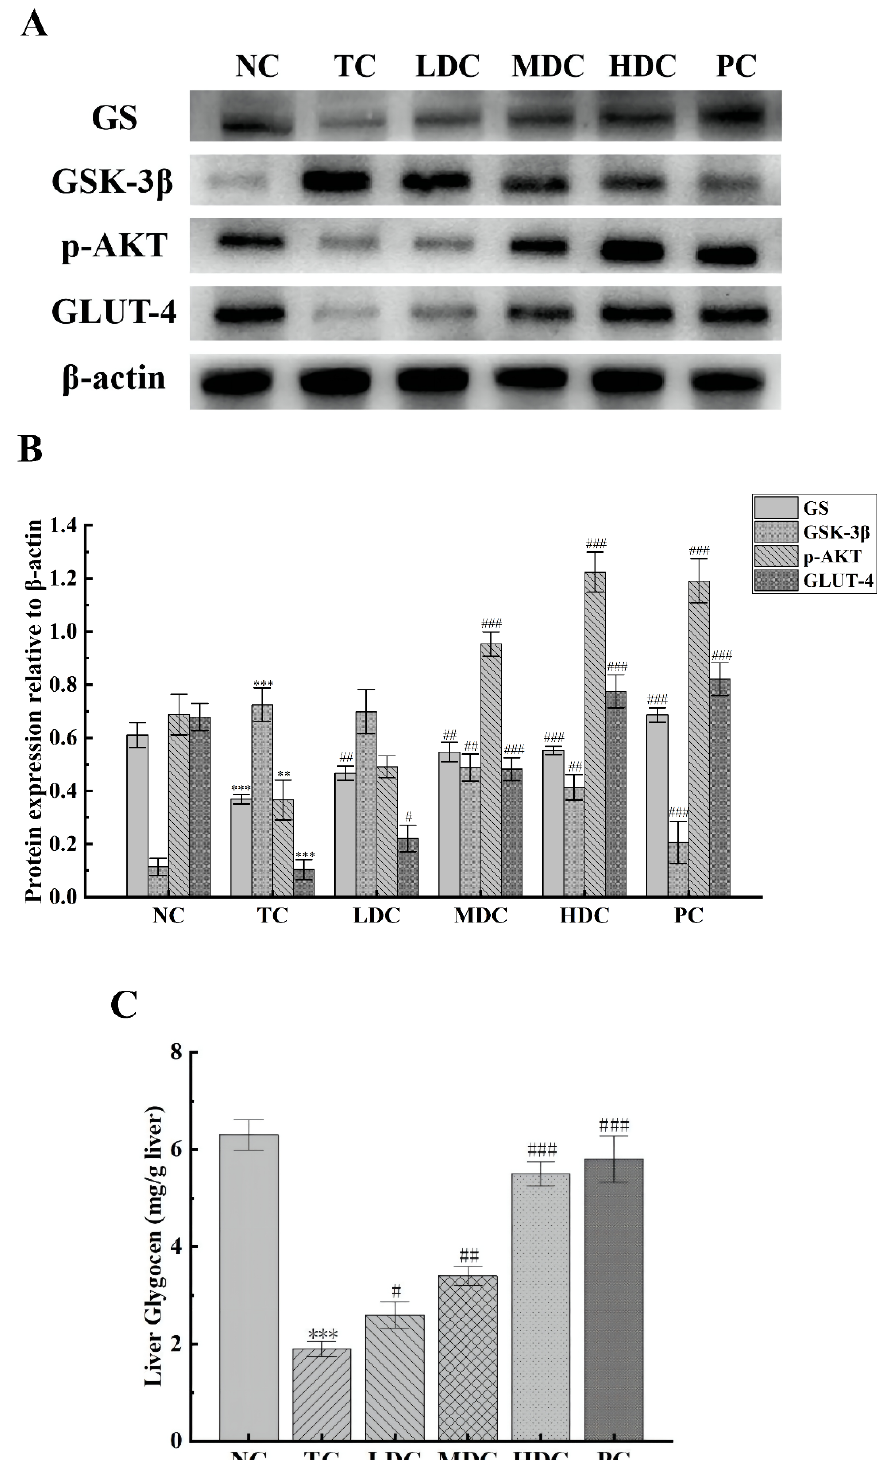
Figure 5. ( A ) The protein expression levels of glycogen synthase (GS), glycogen synthase kinase 3beta (GSK-3β), phosphorylated protein kinase B (p-AKT), and glucose transporter 4 (GLUT-4) were determined via Western blot. ( B ) Protein levels of the above proteins were quantified by densitometry, all of which were normalized to β-actin. ( C ) Liver glycogen content. Data are presented as mean ± SD (n = 8); ** p < 0.01 and *** p < 0.001 compared to the NC group; # p < 0.05, ## p < 0.01, and ### p < 0.001 compared to the TC group.